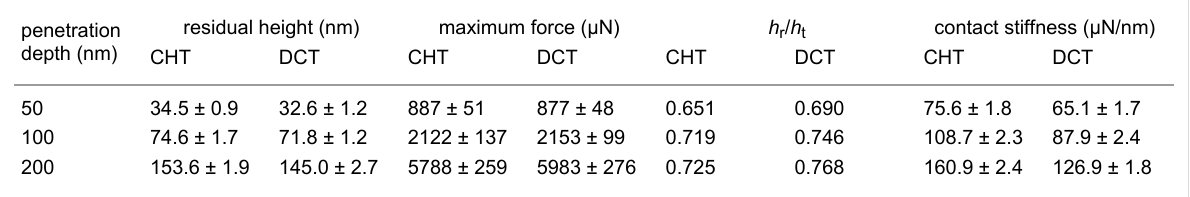
Table 2: Summary of nanoindentation results. penetration depth (nm)